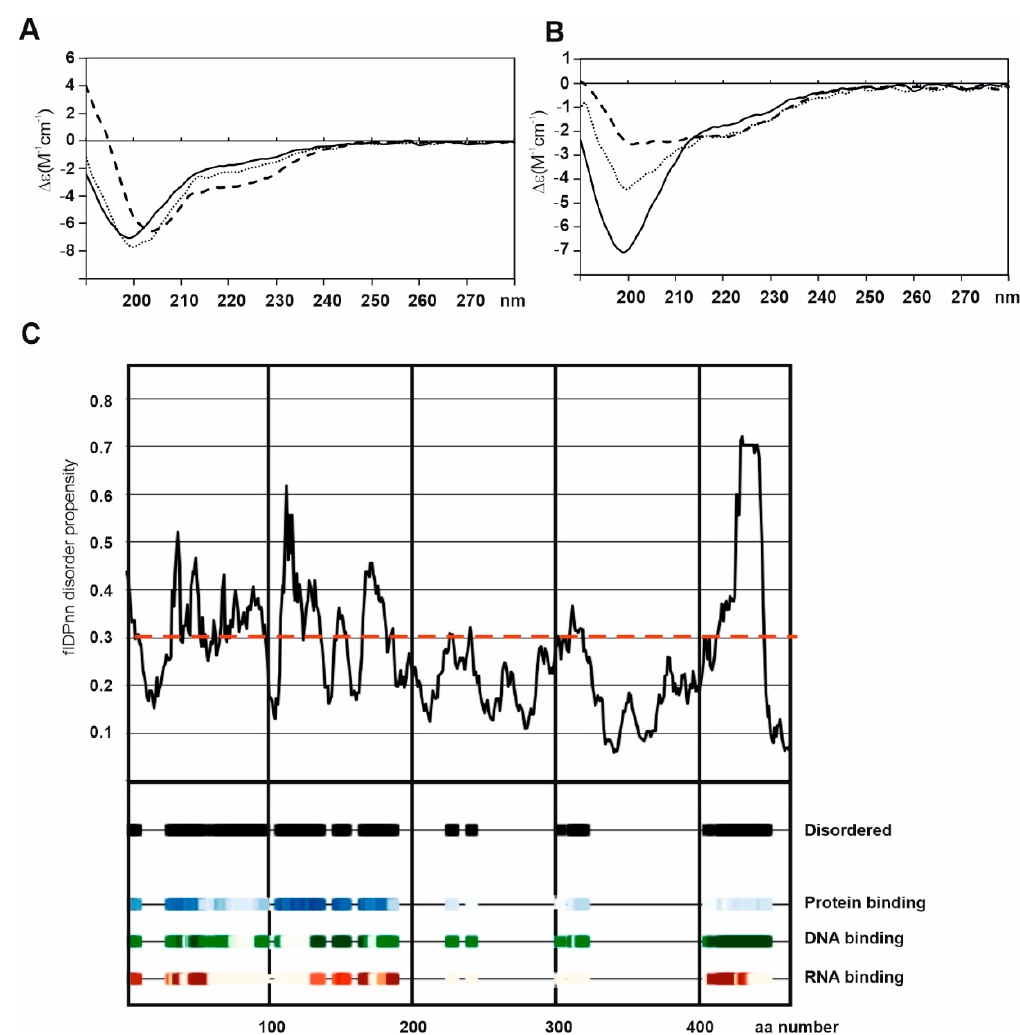
Figure 3. The intrinsically disordered structure of BP180 ICD can undergo charge-induced folding. The intracellular domain (ICD) of BP180 expressed in Escherichia coli was analyzed by circular dichroism spectroscopy. The continuous curve in ( A , B ) shows the spectra of purified soluble BP180 ICD to be typical of that of a random coil with the minimum at 195–200 nm. The addition of negatively charged detergent sodium dodecyl sulfate ( A ) or anionic dimyristoylphosphatidylcholine-dimyristoyliphosphatidylglycerol (DMPC-DMPG) (1:1) lipid vesicles ( B ) induces partial folding as observed by increased Δε below 200 nm, a shift of the minimum toward longer wavelength, and alpha helix-like bending of the curve (dashed curves). The dotted curve in ( A ) represents the spectrum of the BP180 ICD with neutral lipid n-dodecyl phosphocholine and in ( B ) with DMPC-DMPG vesicles + 1mM CaCl 2 (reproduced from Tuusa et al. [36], according to Creative Commons Attribution 4.0 International License (http://creativecommons.org/licenses/by/4.0/, accessed on 11 November 2021). ( C ) New modeling was done for ICD of human BP180 by flDPnn program to map the disordered and protein/nucleic acids binding regions. Regions with values greater than 0.3 are considered to be disordered.